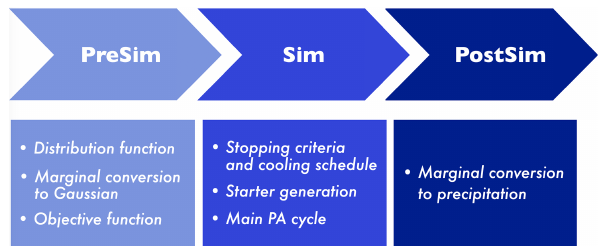
Figure 1. Flowchart of the procedure to simulate surface rainfall fields using the algorithm of